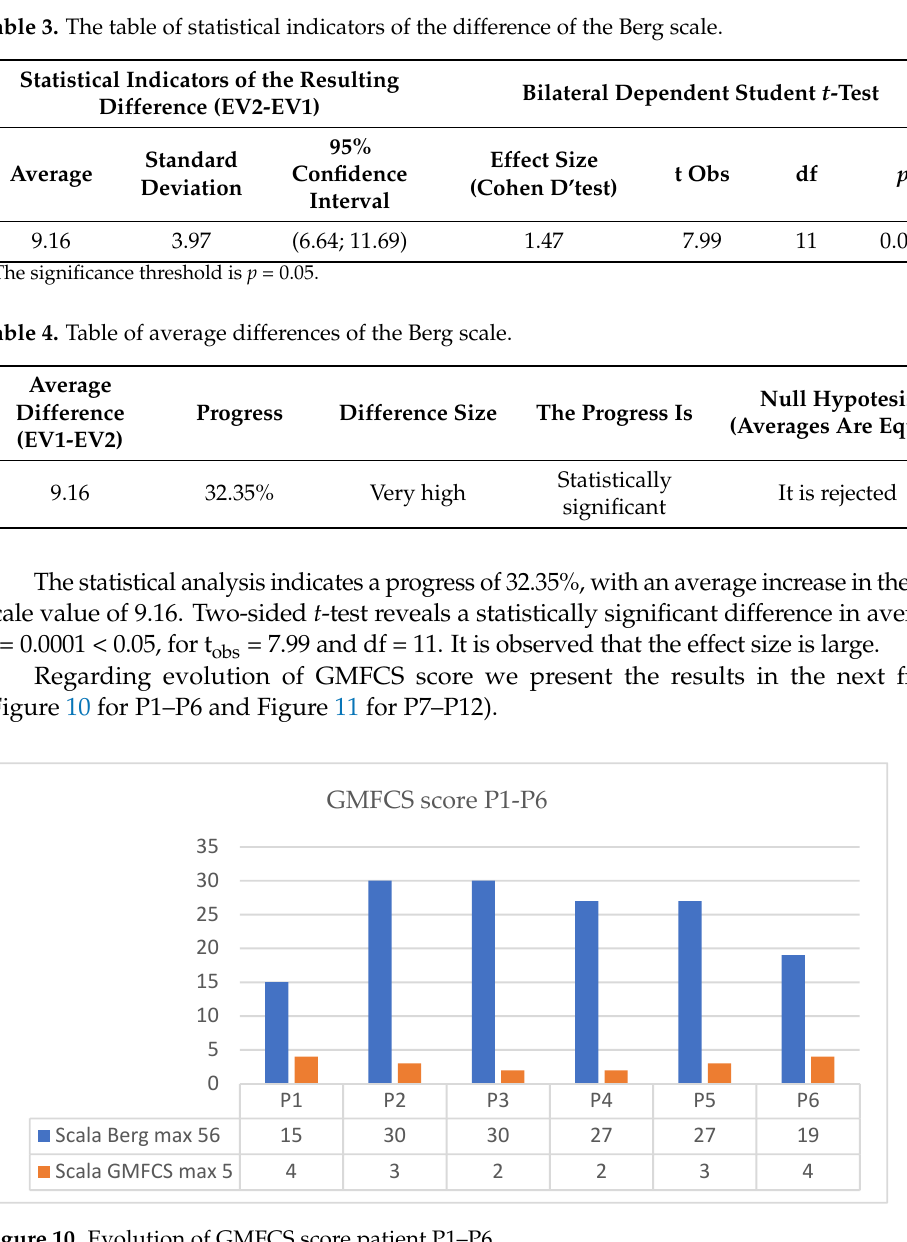
Figure 11. Evolution of GMFCS score patient P7–P12. 3.2. The Results of the Biomechanical Evaluation In this paper, we present the evolution of the data that indicate the distribution of body weight at the level of the two lower limbs, at the two moments of the EV1 and EV2 evaluation. In order to evaluate the evolution as objectively as possible from the recovery of bal- ance and implicitly the efficiency of the combined therapy point of view, we consider that it is necessary to focus our attention on how the patients manage to balance left and right. In this sense, Table 5 shows the body weight distributions (expressed in kg and %) at the level of each leg, at the two moments of the evaluation (EV1 and EV2).